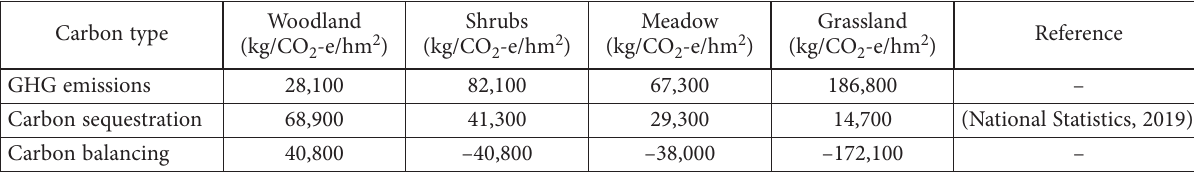
Table 10. Carbon balancing between the GHG emissions and carbon sequestration of the plants over the 100-year maintenance lifetime of the cemetery green space Carbon